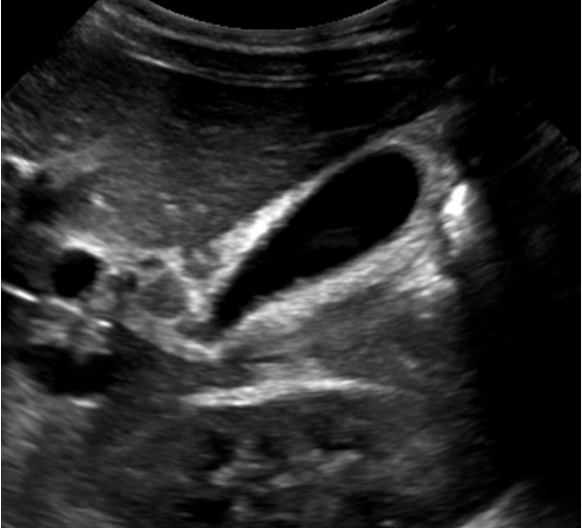
Figure 1. Abdominal ultrasonography showing a thickening of the gallbladder wall of 4.5 mm and pericholecystic edema.